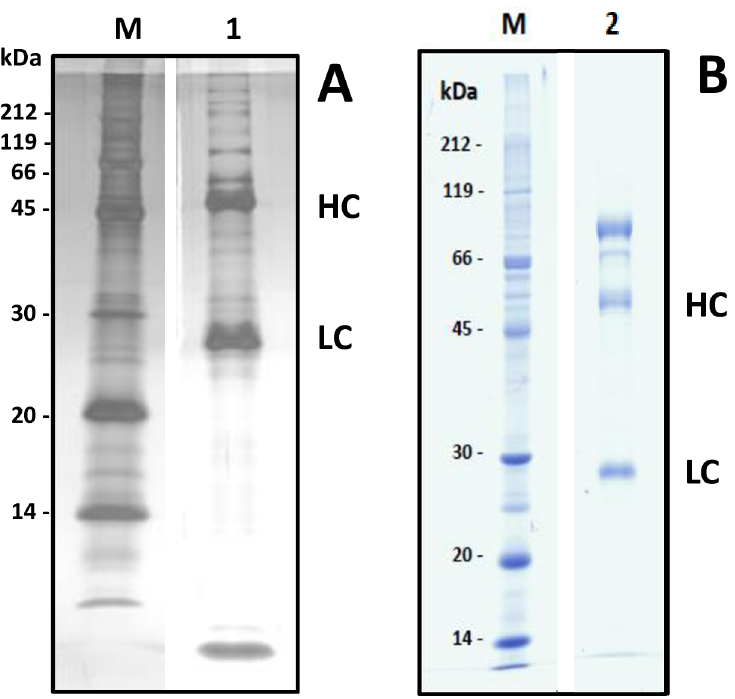
Fig 4. 1DE Gel (15% SDS-PAGE) of IgG preparations and enriched AAB samples of A: human origin (human sample no. 3), Silver stain after run and B: goat ADRB1-AB, Coomassie blue stain after run. M stands for size marker in A and B .